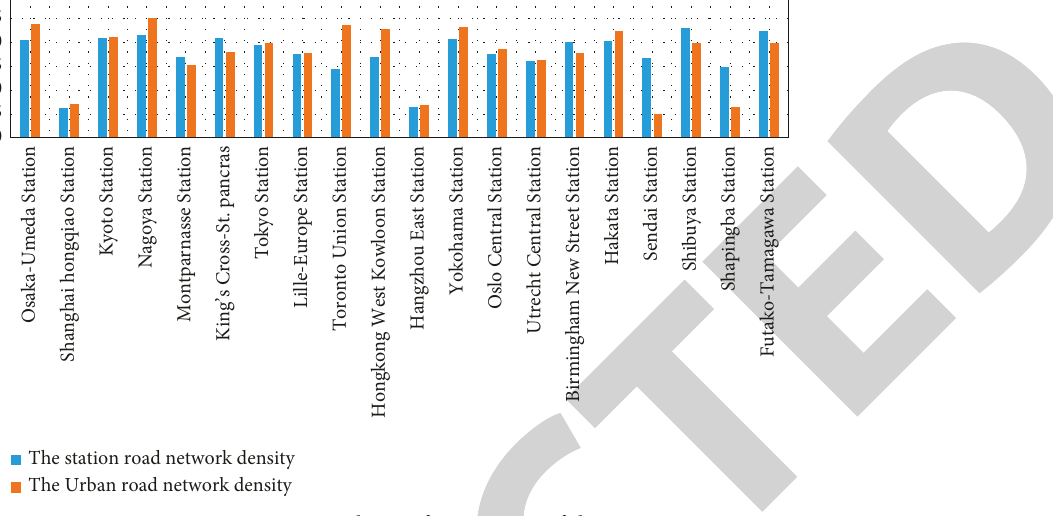
Figure 9: Correspondence of two groups of